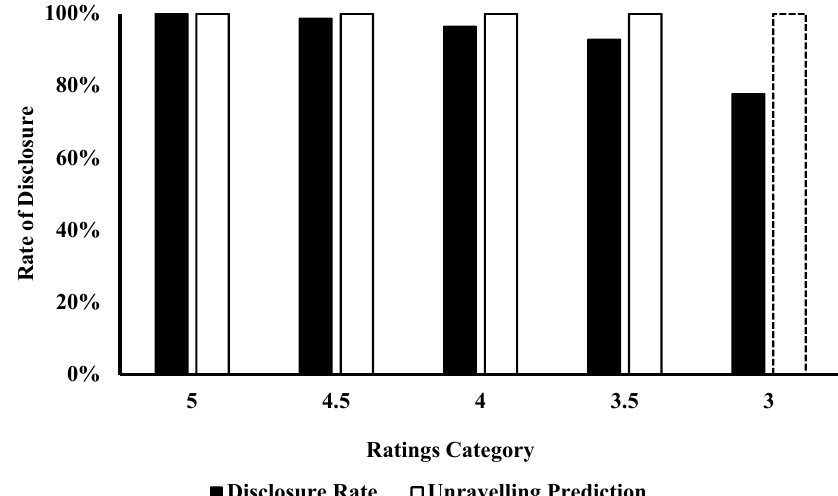
Figure 2. Catalogue Disclosures—Jet2Holidays ( N = 611).